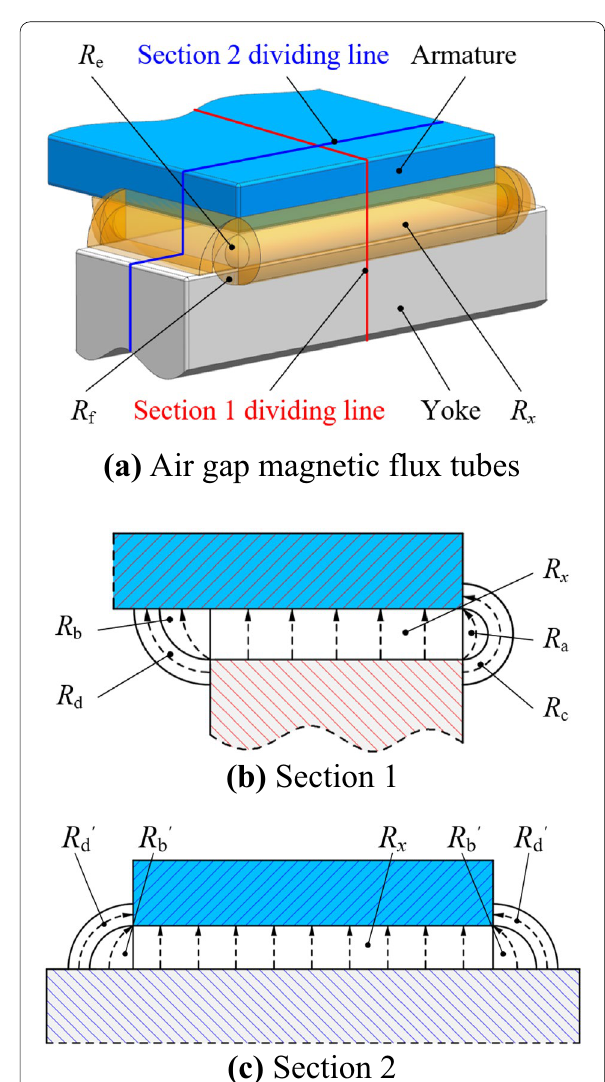
Figure 8 Schematic diagram of various magnetic flux